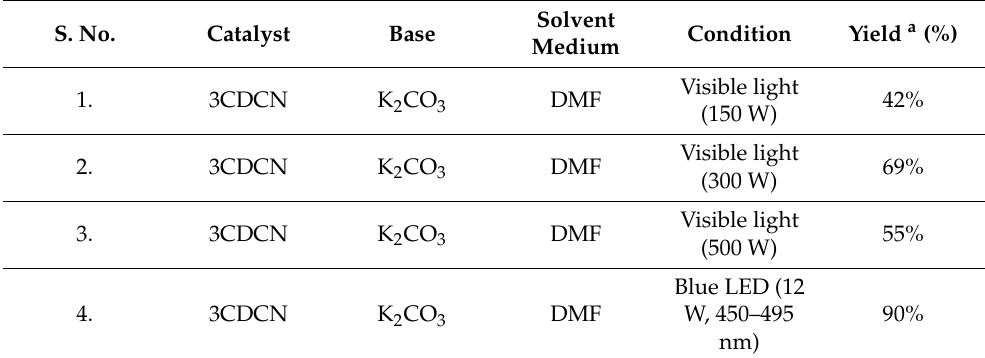
Table 4. Optimization of the light source. S. No. Catalyst Base